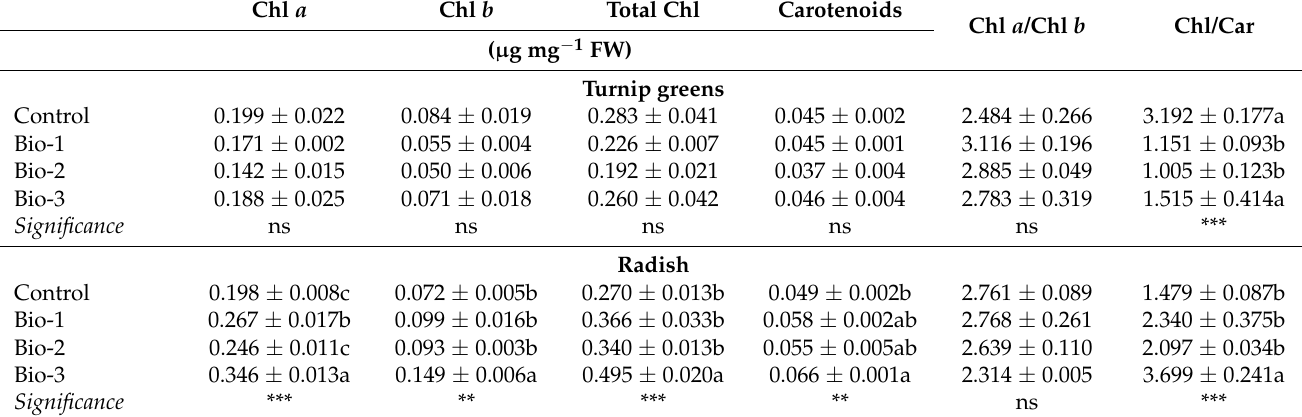
Table 3. Effects of biostimulants (Bio-1 = TRAINER ® ; Bio-2 = AQUAMIN, and Bio-3 = Moringa oleifera leaf extract) on chlorophyll a (Chl a ), b (Chl b ), total chlorophyll (Total Chl), carotenoids ( µ g mg − 1 FW), chlorophyll a/b ratio (Chl a /Chl b ), and chlorophyll/carotenoid ratio (Chl/Car), in turnip greens